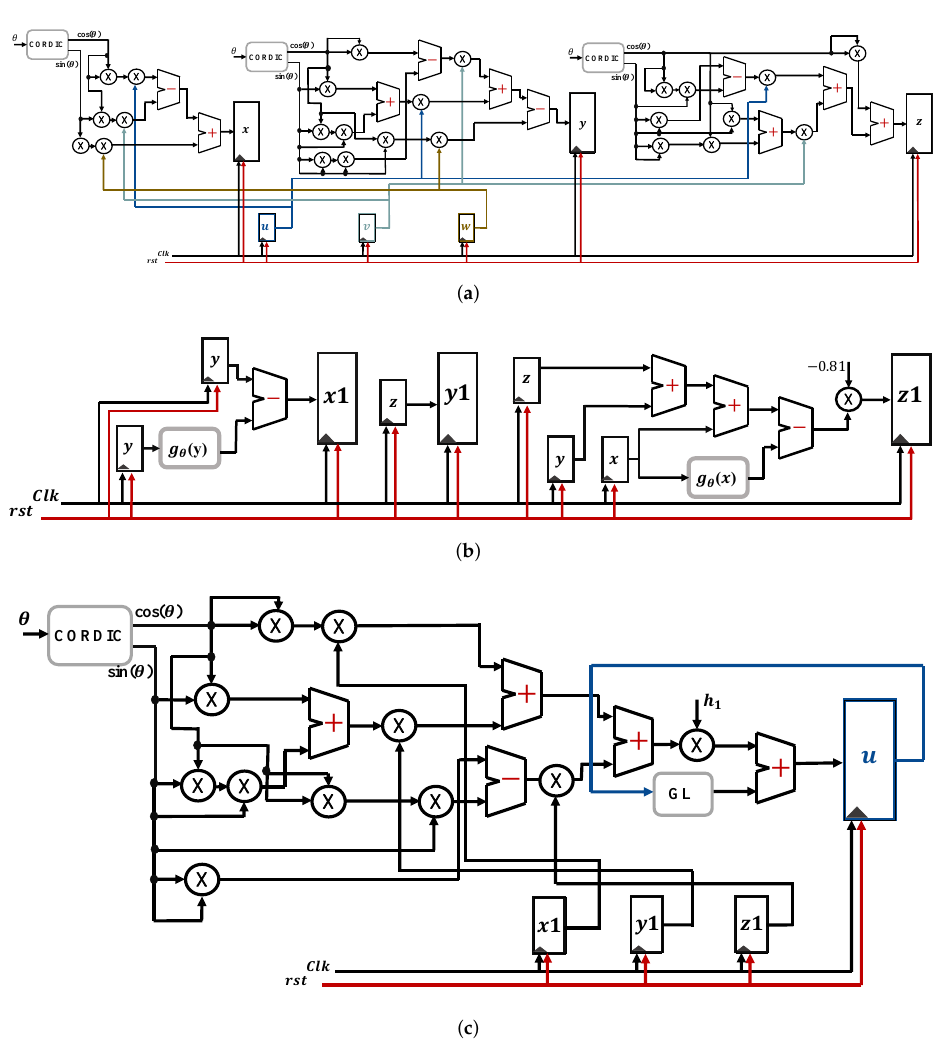
Figure 6. Fractional-order chaotic system 3D rotation: ( a ) first step, ( b ) second step, and ( c ) third